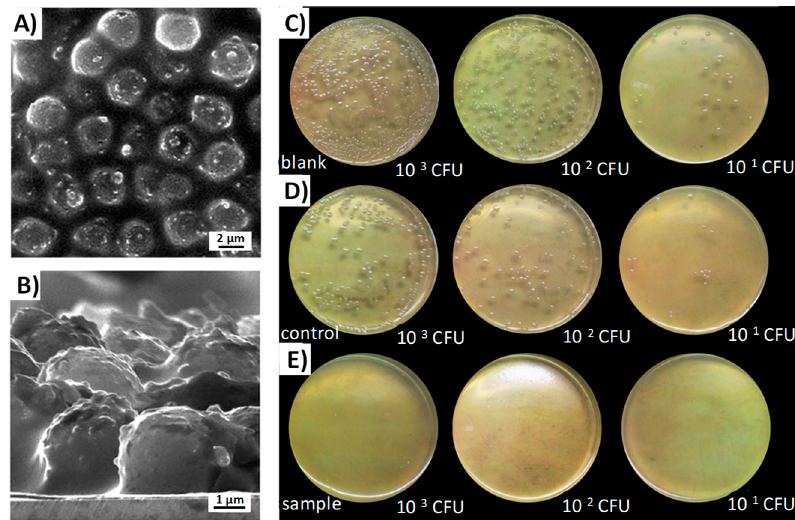
Figure 9. Scanning electron microscopy (SEM) images of ( A ) the film made of mesoporous silica microcapsules with AgNPs supported onto the interior walls, incorporated onto the hydrophobic fluoro-silicone resin (MSMAs/FSR film); ( B ) the cross-sectional structure of the film. Antibacterial activities of various samples against E. coli in different initial bacterial concentrations: ( C ) the blank (without film); ( D ) the control (with the pure fluoro-silicone resin (FSR) film); ( E ) the sample (with the MSMAs/FSR film) (adapted with permission from [171], copyright The Royal Society of Chemistry 2014). Table 4. Mesoporous Silica Materials for Preventing Biofilm Formation.